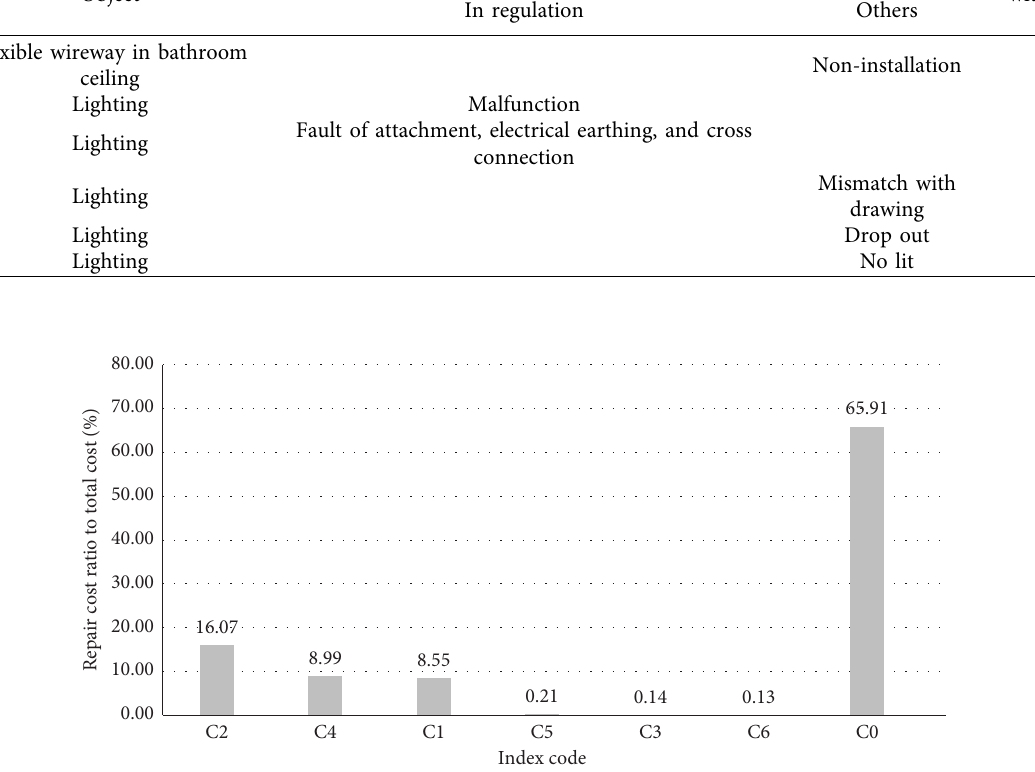
Figure 10: Pareto graph on repair cost of index C